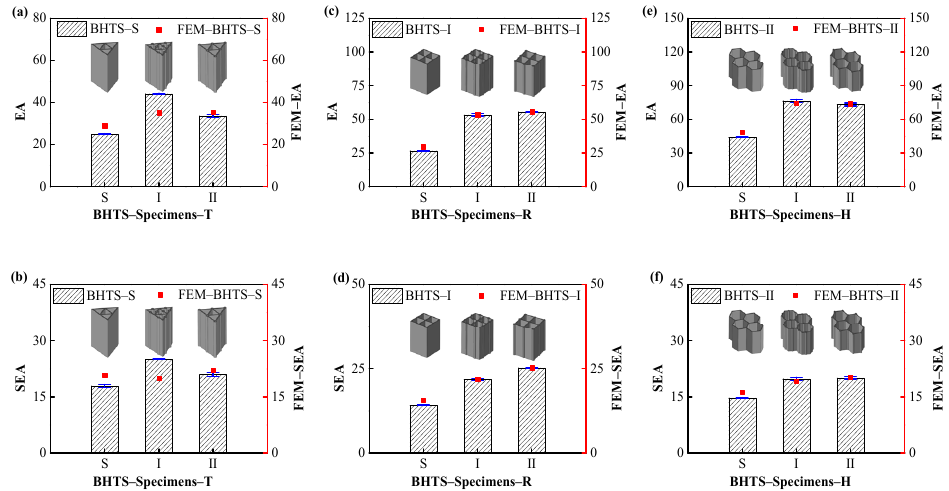
Figure 12. EA evaluation indexes of BHTS at different hollow column positions: ( a , c , e ) EA; ( b , d , f ) SEA.